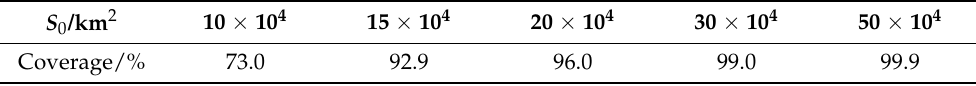
Table 1. Area coverage under different assignments of S 0